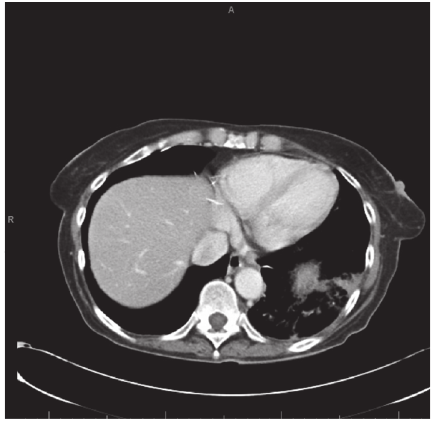
Figure 1: Chest CT scan of case 2 showing pulmonary embolism.